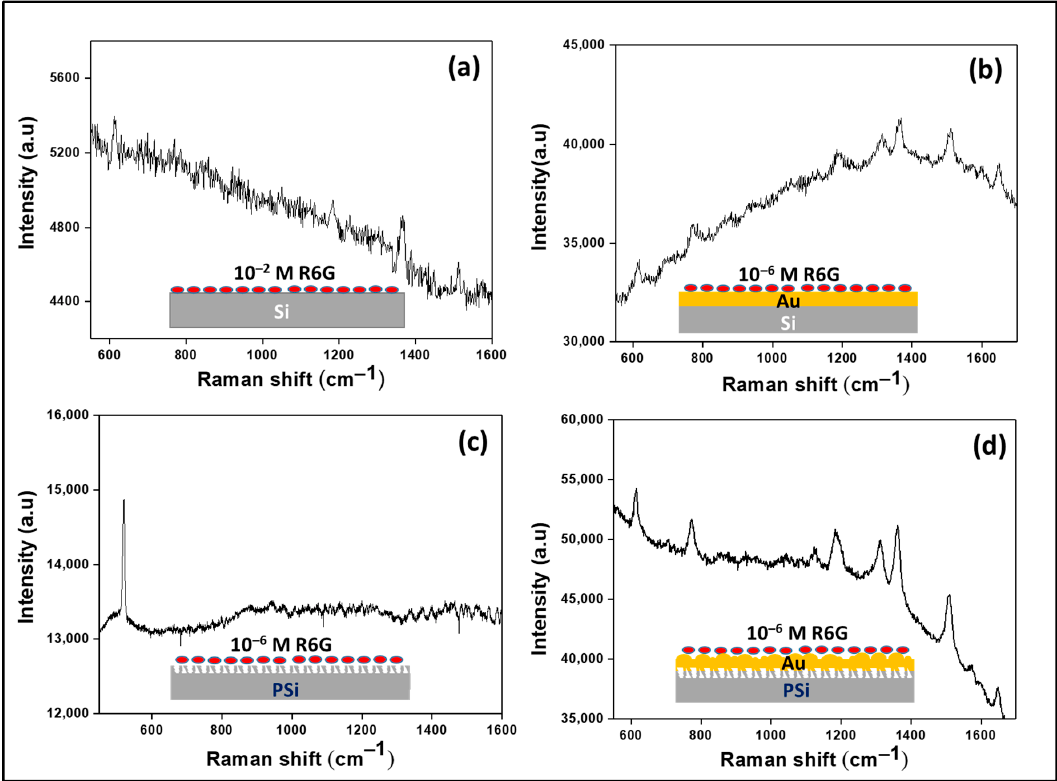
Figure 3. Schematic of the (a) Si, (b) Si-Au, (c) PSi, and (d) PSi-Au substrates and the corresponding Raman spectra plotted without normalization for the different concentration of R6G dye.